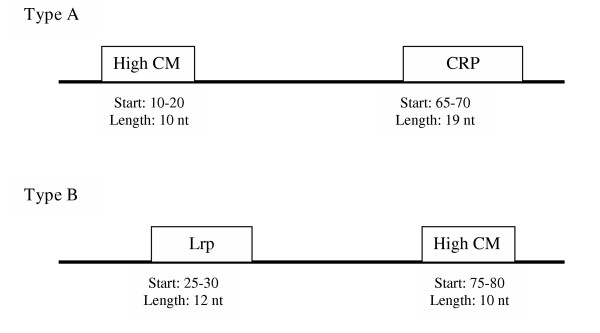
Construction of the synthetic positive set of sequences in Experiment 1. The range of starting positions and length of each added feature are indicated (CM = conformational mobility, CRP = cAMP receptor protein, Lrp = leucine-responsive regulatory protein).